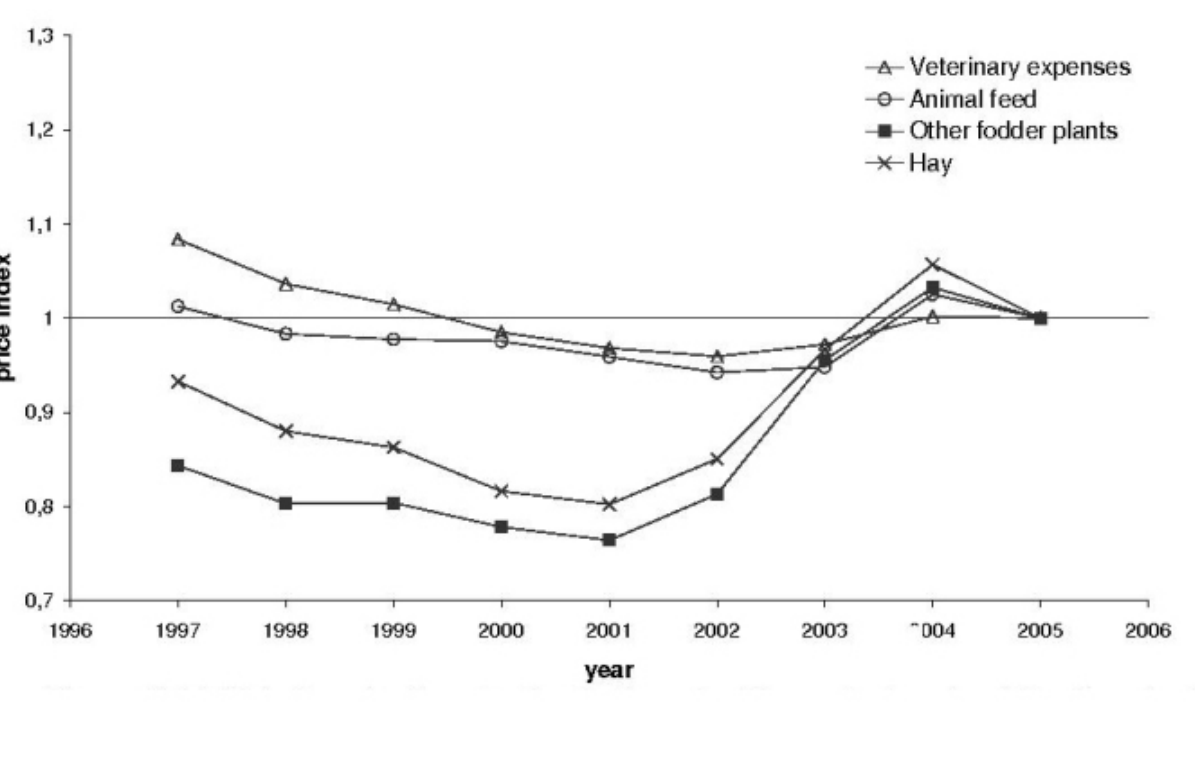
Figure 6. Deflated agricultural price indices for the main inputs of the livestock sector in Greece (reference year = 2005;